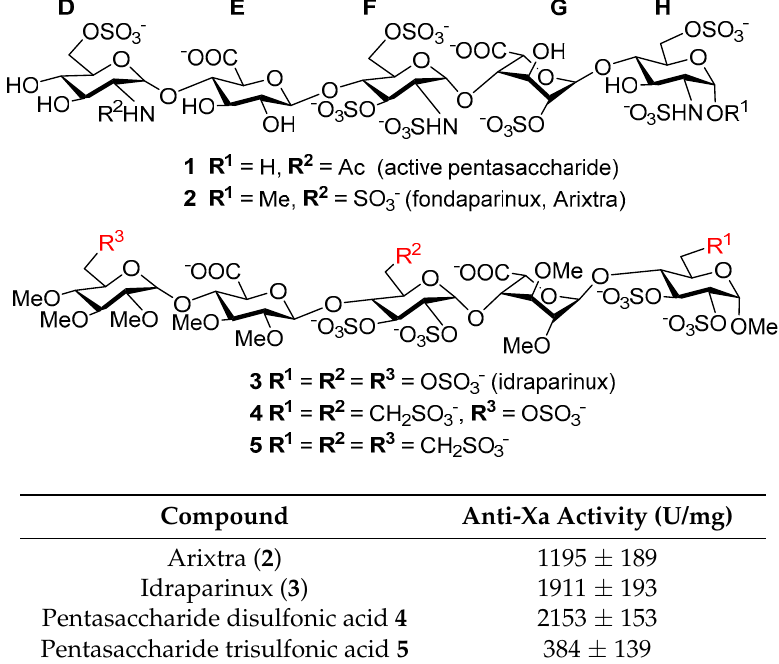
Figure 1. The antithrombin-binding pentasaccharide domain of heparin ( 1 ) and structures and factor Xa inhibitory activities of the synthetic analogues 2 – 5 .